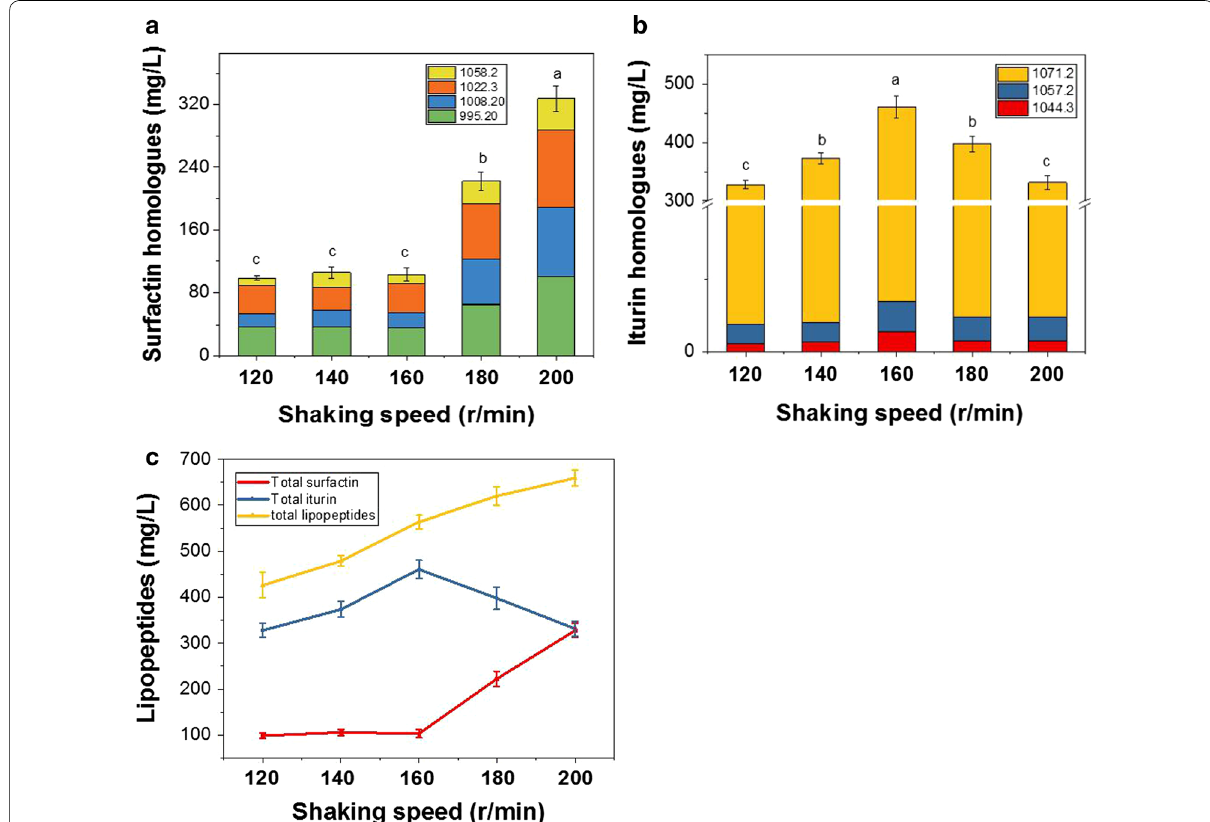
Fig. 2 Concentration of surfactin homologues ( a ), iturin homologues ( b ) and lipopeptide ( c ) production at different shaking speeds. Values are expressed as mean SD, n 5. The different letters indicate significant differences between treatments (p < ± =